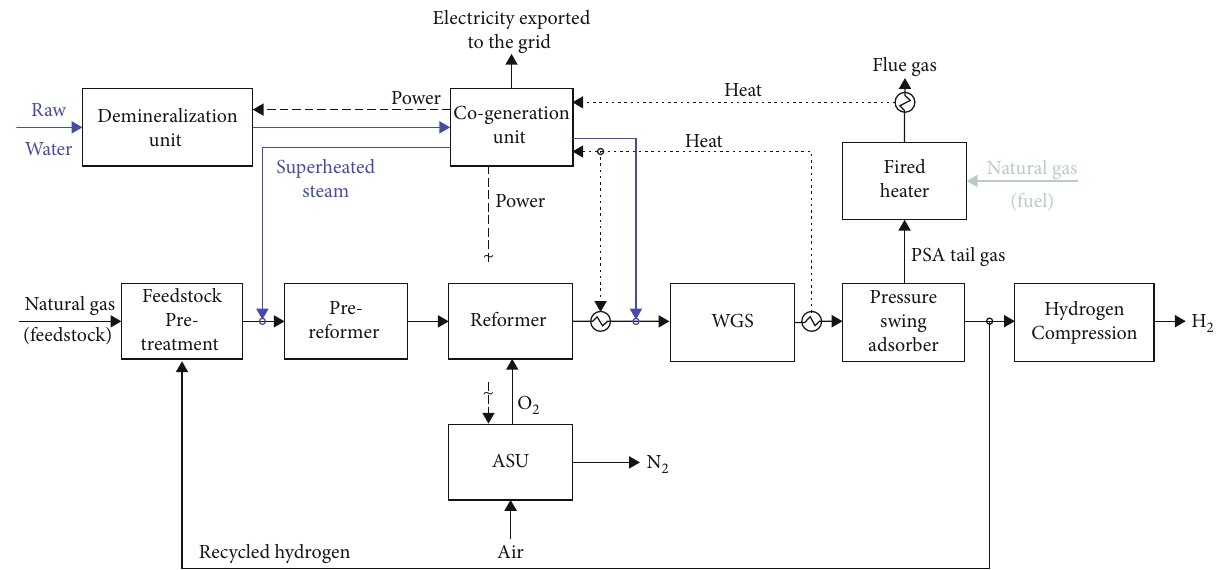
Figure 13: Hydrogen production via steam methane reforming; natural gas or biomethane is desulphurized in a pre-treatment section